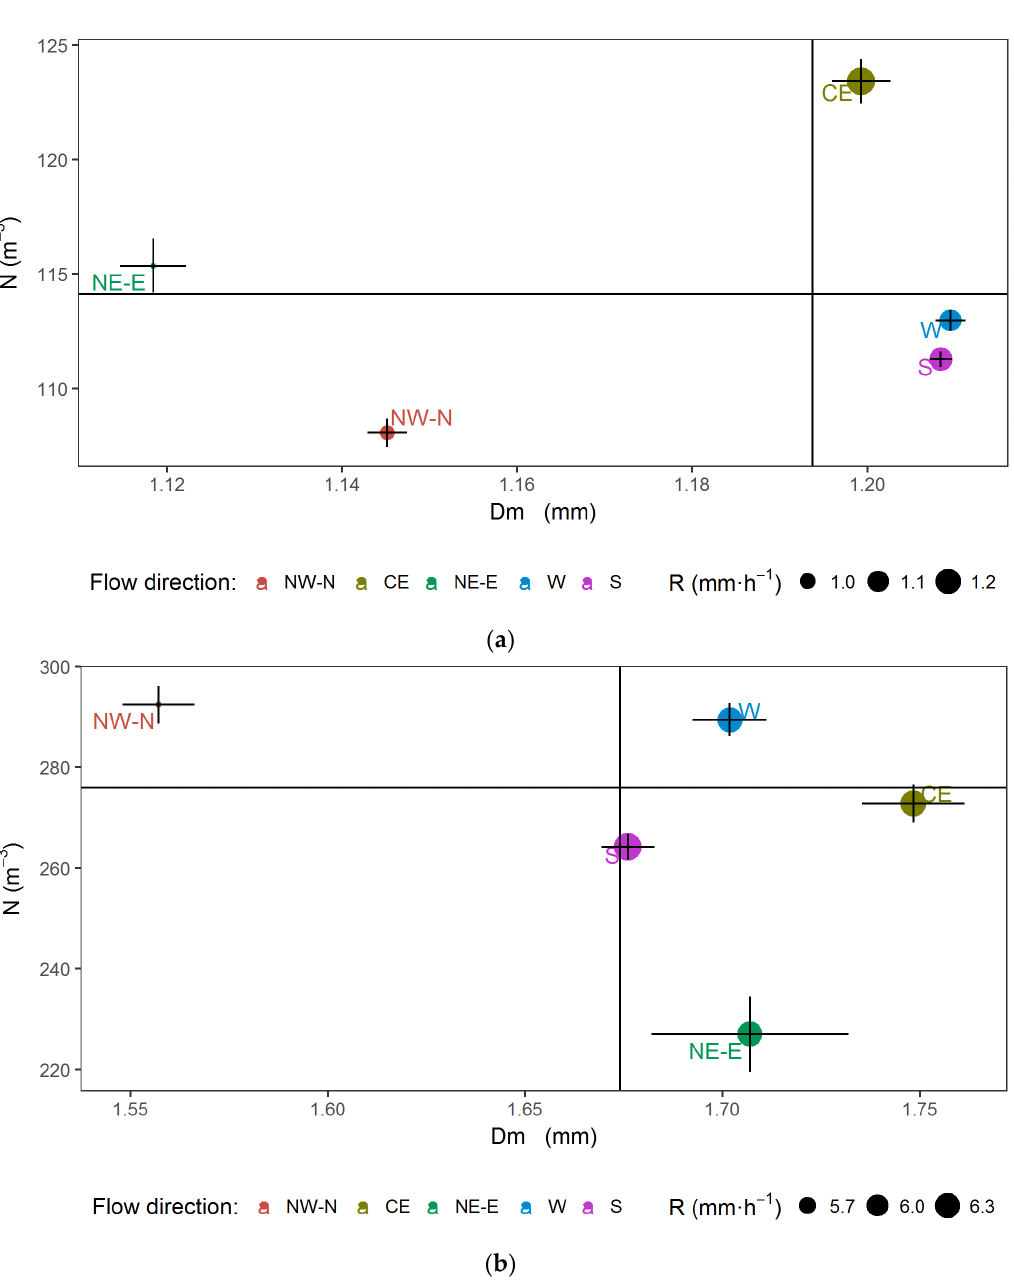
Figure 6. Scatter plot of rain parameters for each flow direction with the mean mass weighted diameter (D m ) for each flow direction on the horizontal axis and the mean concentration (N) for each flow direction on the vertical axis. The size of each dot represents the rain intensity associated with the corresponding flow direction. The colors indicate the five flow directions (see Table 1) in ( a ) stratiform rain and ( b ) convective rain. The horizontal lines represent the standard error of D m . The vertical lines represent the standard error of N. Note the difference in absolute values for the two panels.